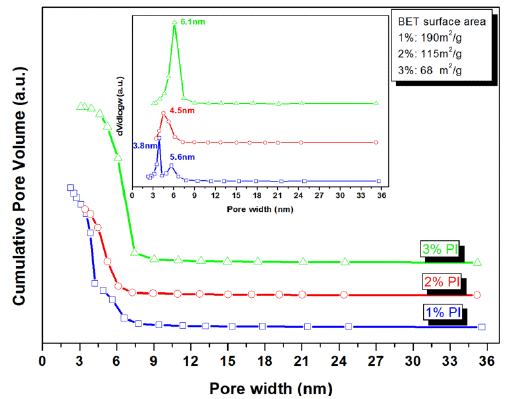
Figure 2. N 2 adsorption–desorption results of HRI coatings with different photoinitiator (PI) concentrations.